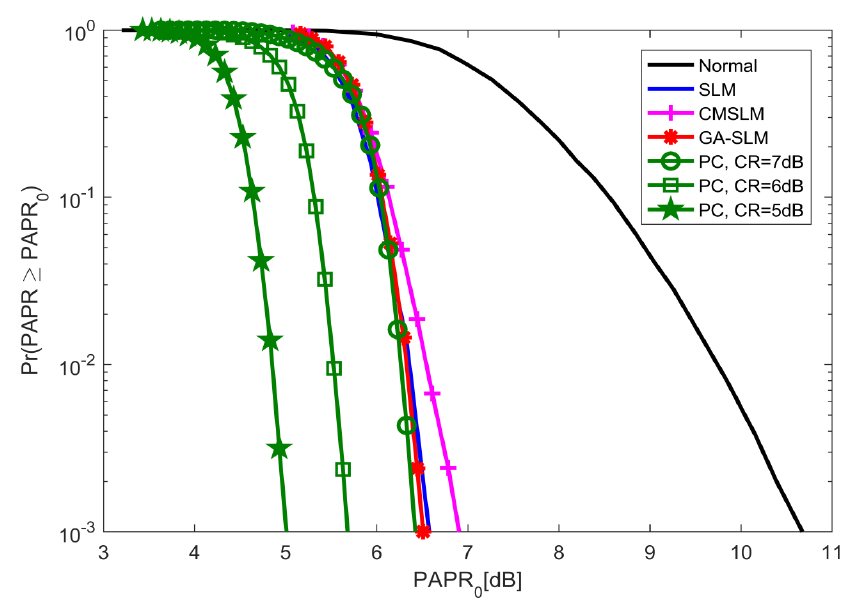
Figure 20. CCDF of the proposed method compared with the Selective Mapping Technique (SLM) and its variants.